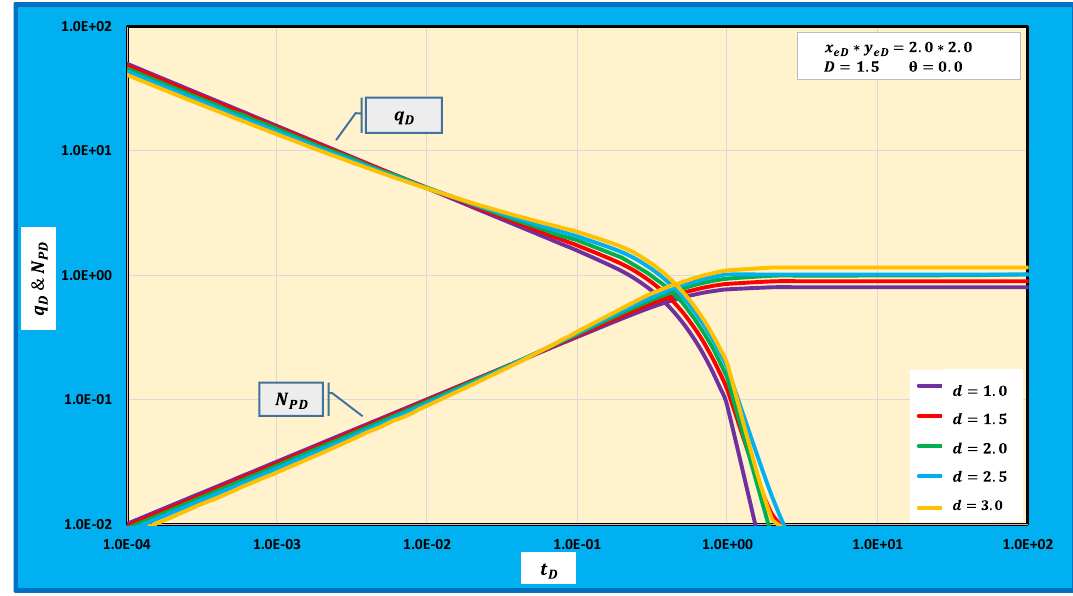
Fig. 12 Flow rate and cumulative production behaviors for different mass fractal